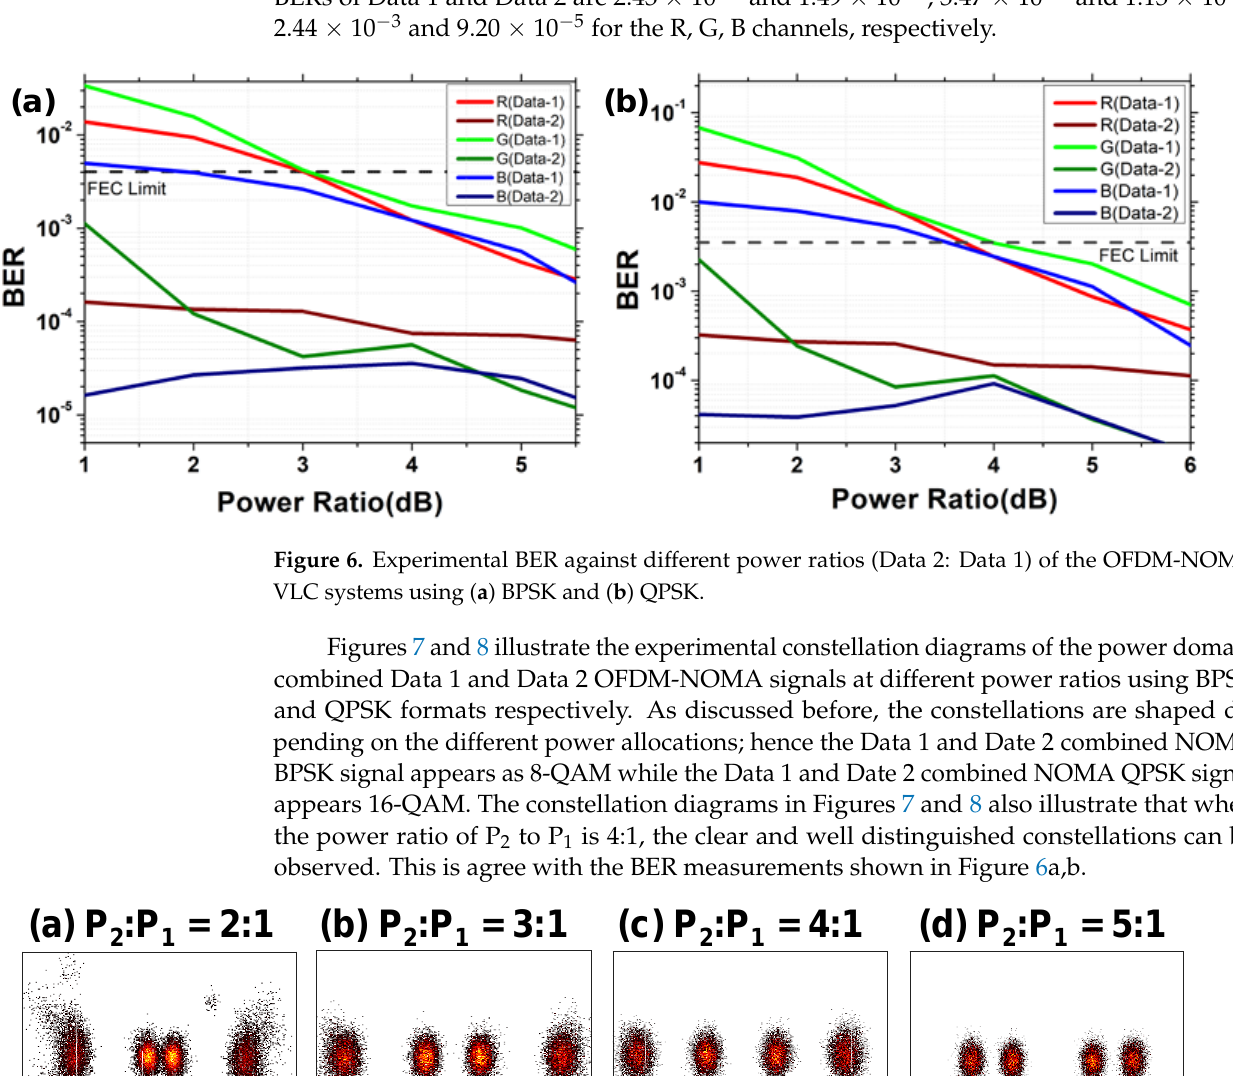
Figure 7. Experimental constellation diagrams of the power domain combined Data 1 and Data 2 OFDM-NOMA signals at different power ratios using BPSK.